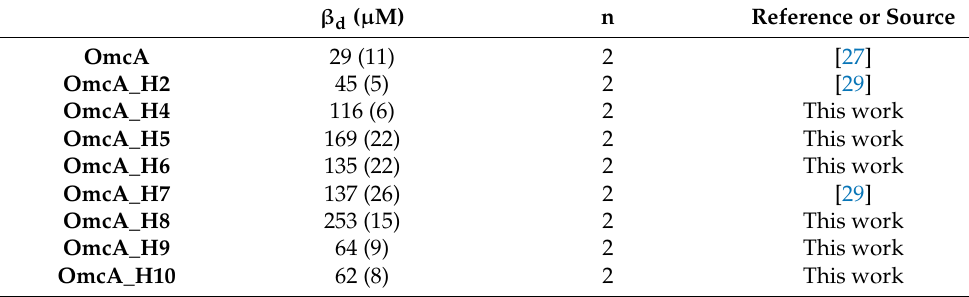
Table 3. Dissociation constants and stoichiometry of binding of FMN by native OmcA and all the OmcA mutants. Values in parenthesis indicate the standard error of the fitted value determined from the diagonal elements of the covariance